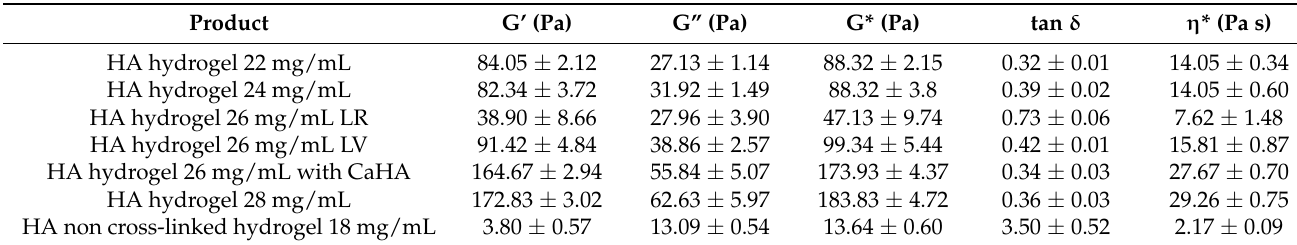
Table 2. Rheological characterization of seven HA hydrogel dermal fillers provided by Matex Lab S.p.A. obtained at a fixed shear strain (1%) and temperature (25 ◦ C) in their linear viscoelastic region (LVER). Data are represented as averages and standard deviations (SDs).